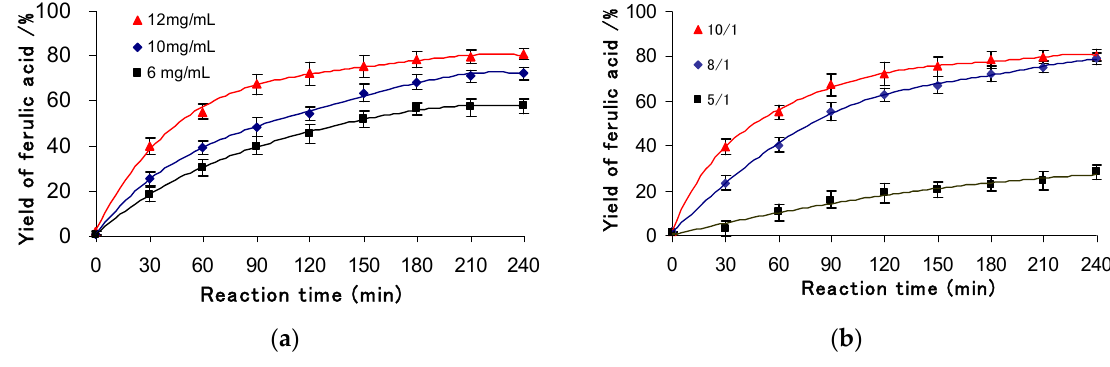
Figure 3. Effect of initial concentration of γ -oryzanol ( a ) and KOH/ γ -oryzanol ( wt / wt ) ratio on yield of ferulic acid (FA) ( b )